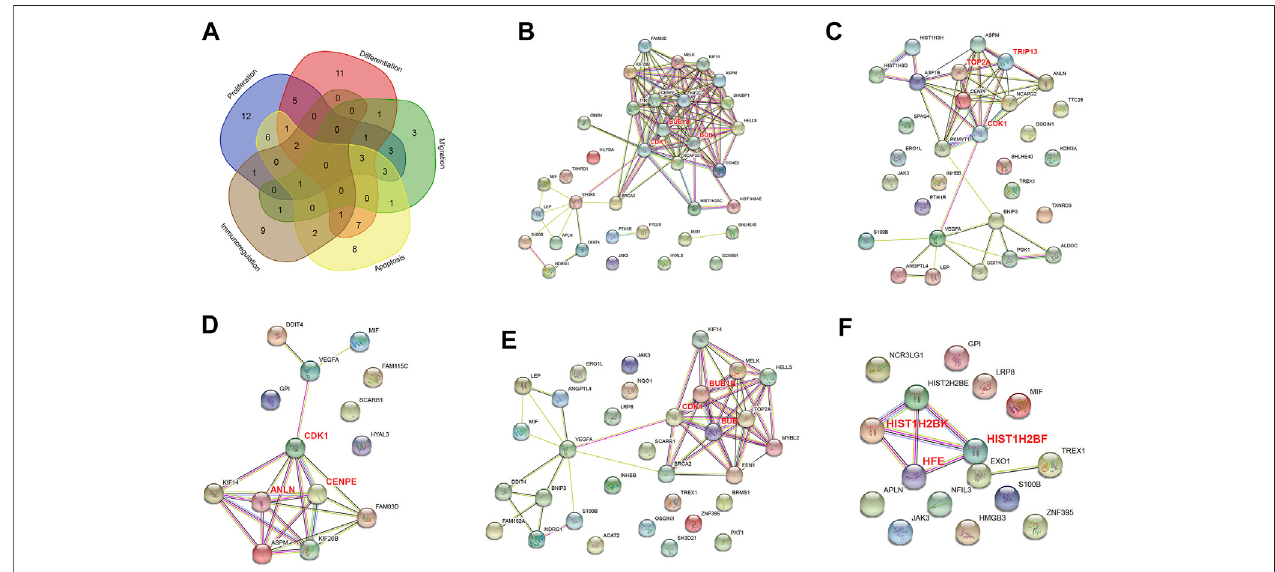
FIGURE 4 | PPI networks of differentially expressed genes (DEGs) in normoxia-treated in fl ammatory hPDLSCs (I_N) compared with hypoxia-treated in fl ammatory hPDLSCs (I_H). (A) Venn diagram of DEGs associated with proliferation, differentiation, migration, apoptosis, and immunoregulation. PPI networks of DEGs associated with proliferation (B) , differentiation (C) , migration (D) , apoptosis (E) , and immunoregulation (F) . The genes in bold red are the three most highly correlated hub genes identi fi ed by CytoHubba.